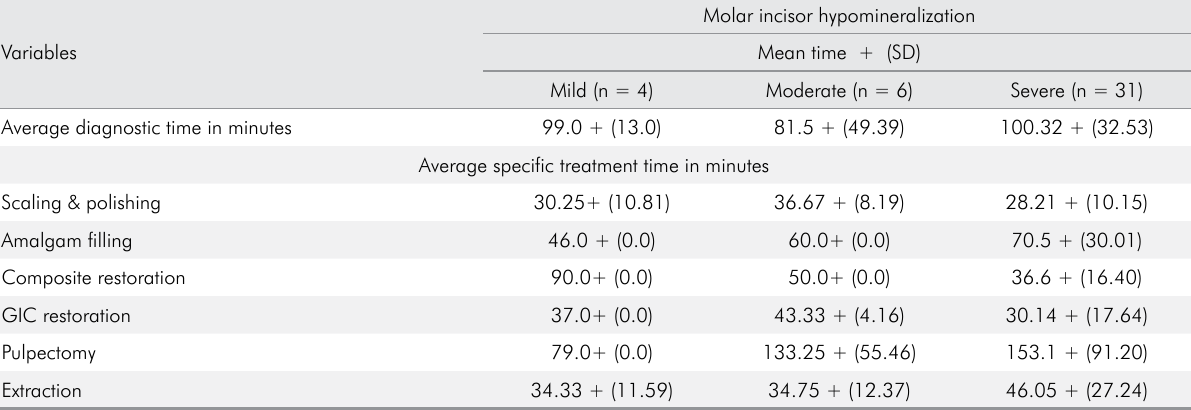
Table 3. Average clinical times and average number of dental visits for management of children with different levels of molar incisor hypomineralization